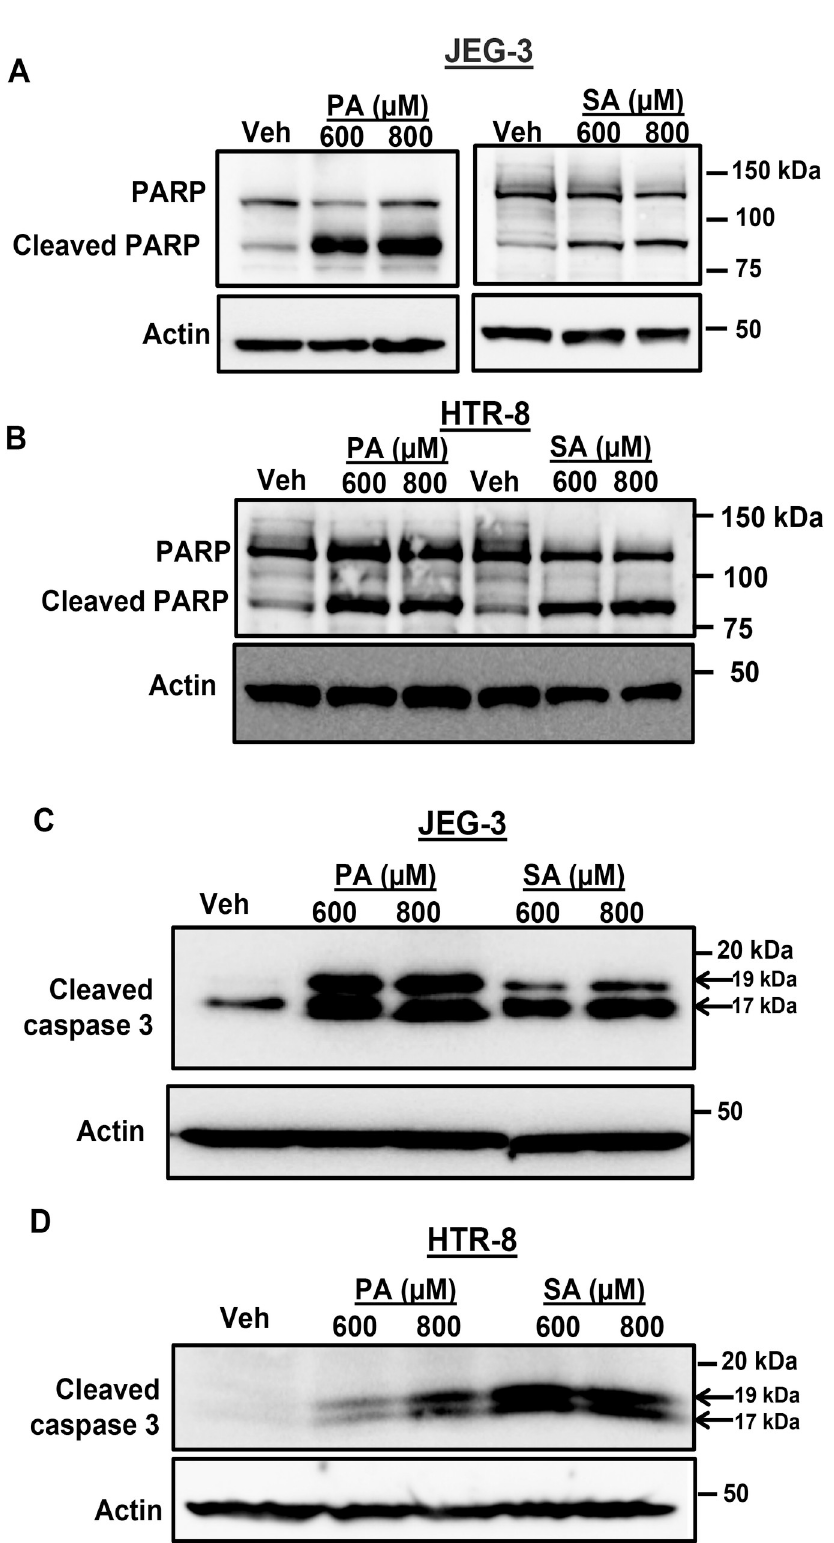
Fig 3. Biochemical evidence for FFA-induced trophoblast lipoapoptosis. Cells were treated with palmitate (PA), stearate (SA) (600–800 μ M) or Vehicle (Veh) for 24 h. (A) JEG-3 cells treated with 600–800 μ M of PA or SA